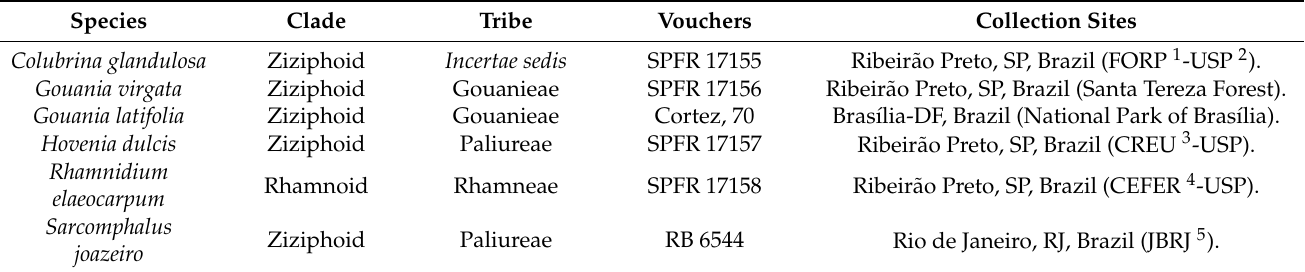
Table 2. Rhamnaceae species sampled in the present